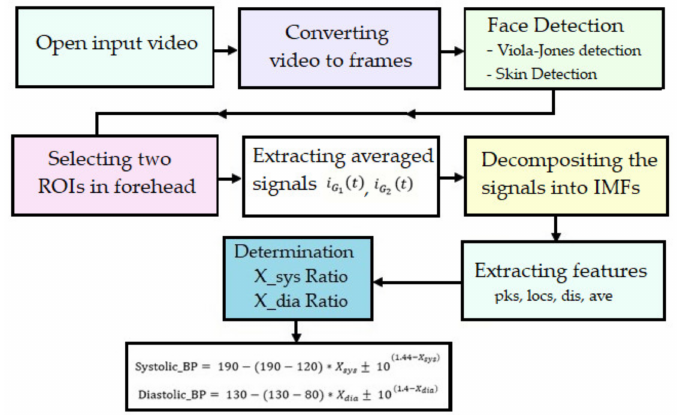
Figure 2. The block diagram of the proposed imaging